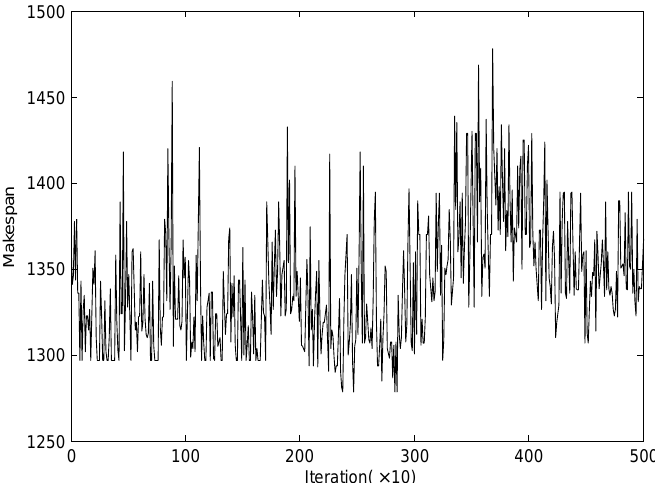
Figure 7. Solution value versus iteration in the benchmark instance ta001